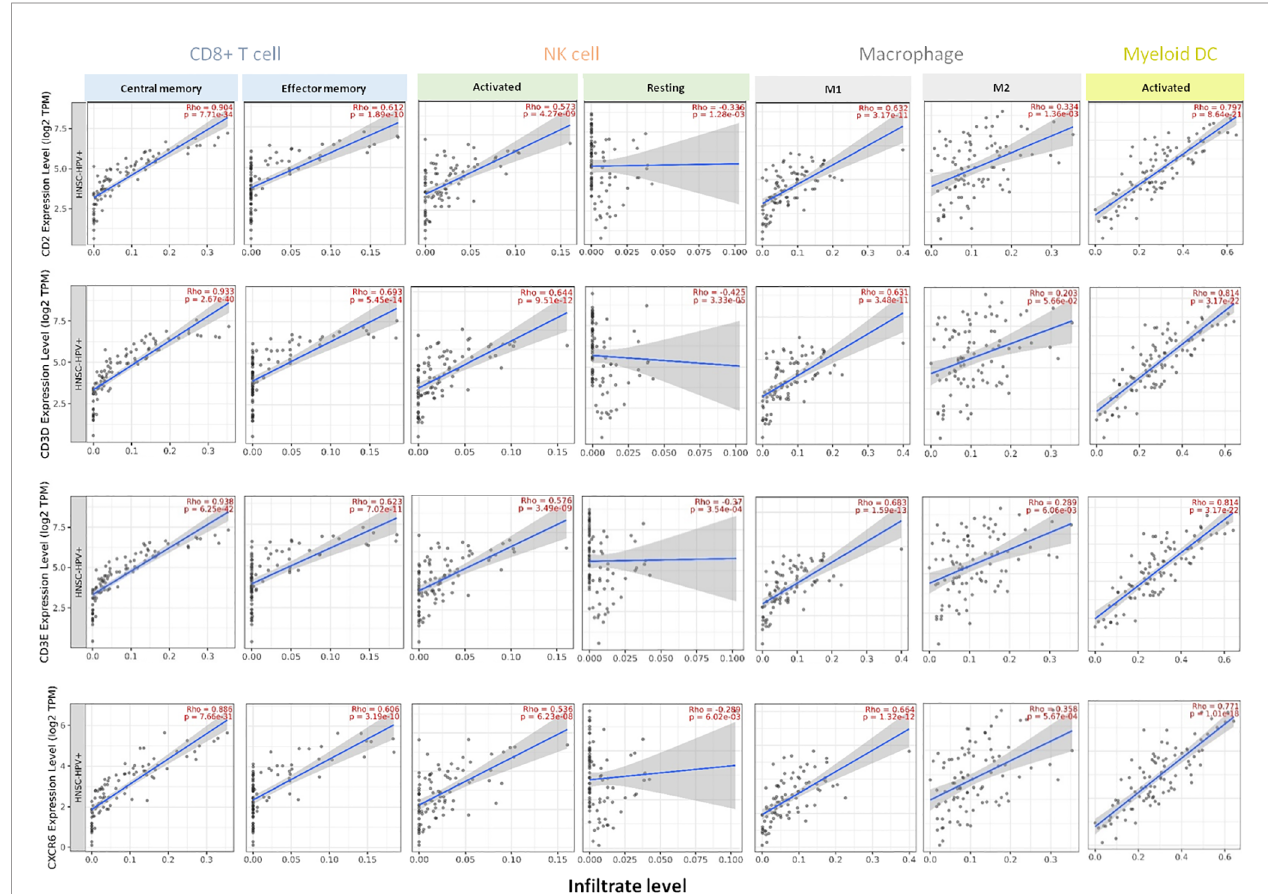
FIGURE 3 | Association of the expression of CD2 , CD3D , CD3E , CXCR6 with speci fi c tumor-in fi ltrating immune cell populations in HPV-positive HNSCC patients. Expression of each gene and association with the presence of CD8+ T cells (central memory and effector memory subsets), NK cells (activated and resting), macrophages (M1 and M2 types), and activated myeloid dendritic cells in HPV-positive HNSCC (n = 98). Each panel presents the relationship between in fi ltrates estimation value with the purity-adjusted spearman ’ s correlation parameter Rho and gene expression join p value < 0.001. Rho value > 0 represents a positive correlation, and Rho < 0 represents a negative correlation. Association with immune cell populations was provided by TIMER 2.0 software and was correlated with transcriptome expression level of each immune gene, as described in Material and Methods